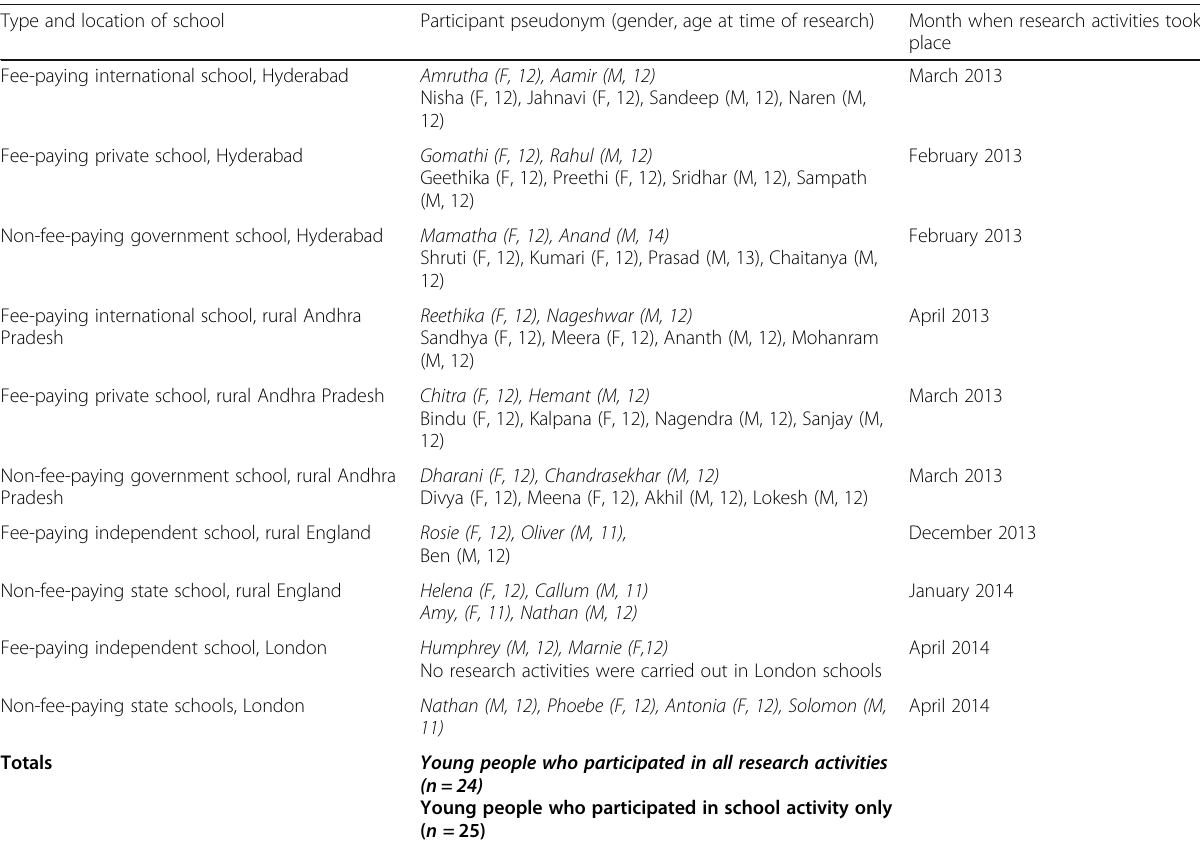
Type and location of